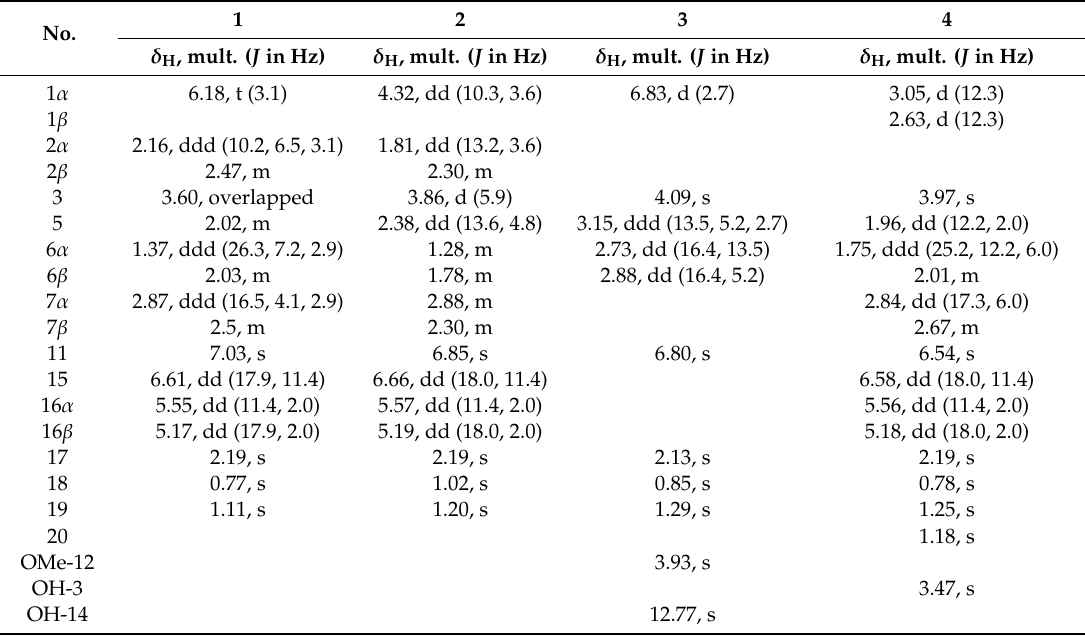
Table 1. 1 H (600 MHz) NMR data for compounds 1 – 4 in CDCl 3 .